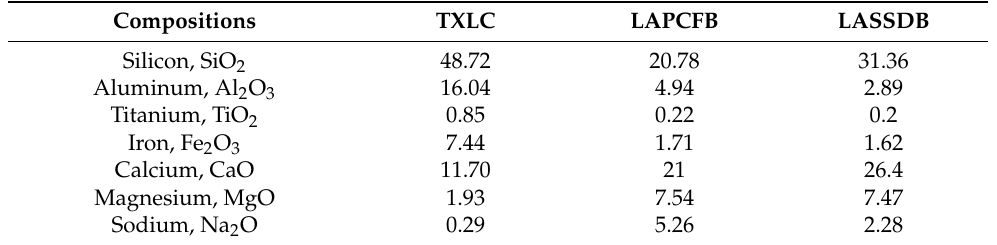
Table 4. Mineral analysis of ash (% mass, ash was calcined ∼ = 1100 ◦ F (600 ◦ C) prior to analysis). Compositions